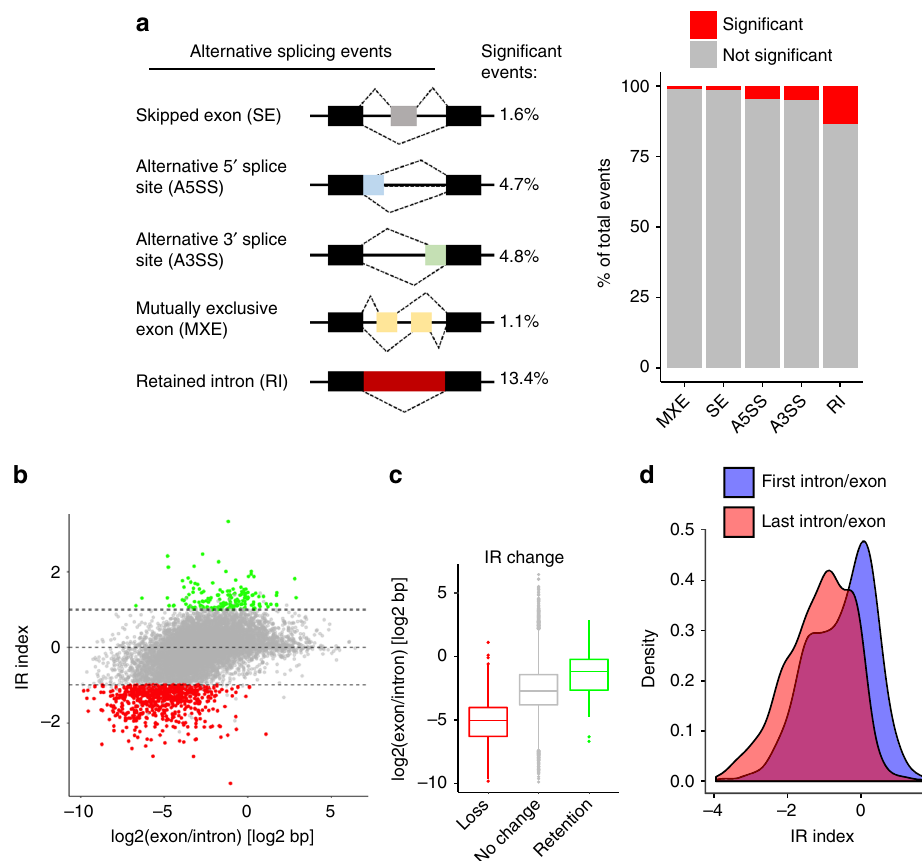
Fig. 4 CDK12/13 inhibition results in minimal splicing alterations. a Diagrammatic representation (left) and bar plot of splicing events (right) observed in TT-seq analysis of NB cells treated with THZ531 (400 nM) for 2 h. b Scatterplot of intron retention index (IR index) vs. the ratio of exon and intron lengths in log2 scale. Genes with an IR index >1 or ≤ 1 display intron retention and loss respectively (adjusted p < 0.05, Fisher ’ s exact test). c Box plot illustrating the length distributions of genes that display intron loss or retention. The center line indicates the median for each data set. d Density plots illustrating the contributions of the proximal ( fi rst intron/exon) and distal (last intron/exon) gene regions in calculation of the IR index. Comparison of IR index distribution between proximal and distal intron/exon pairs ( p = 0, Kolmogorov-Smirnov